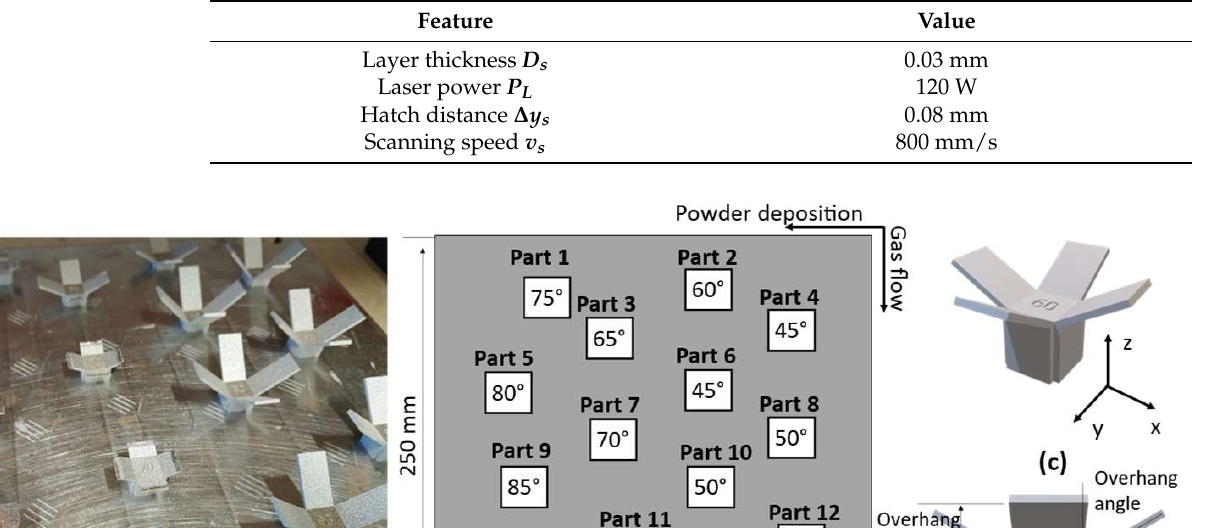
Table 2. Job property of training set generation.